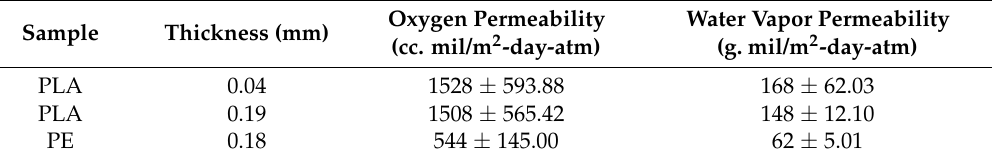
Table 3. Permeability values for PLA and PE films.